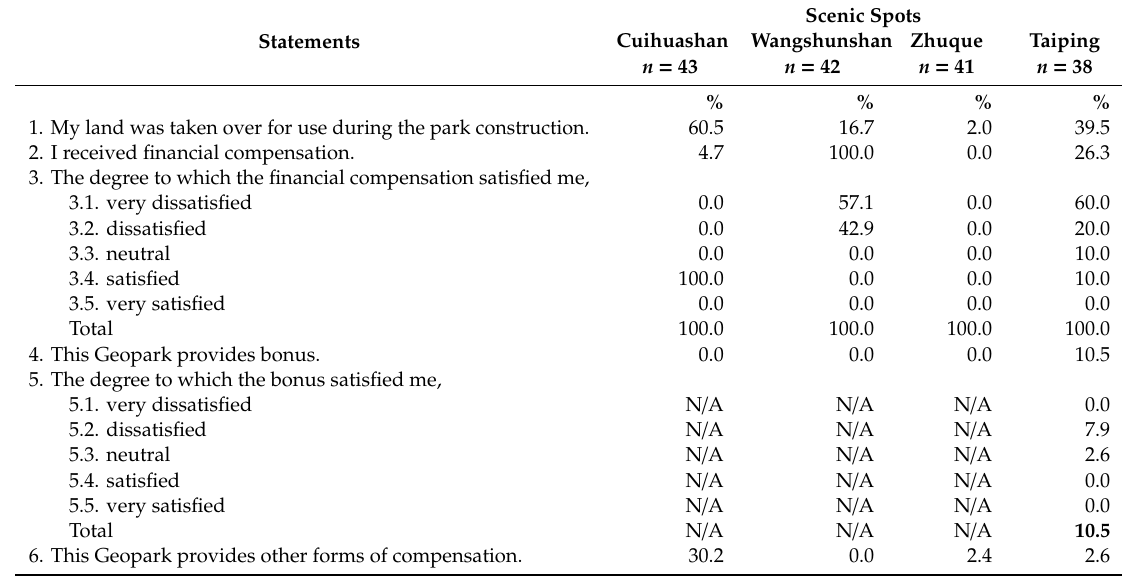
Table A4. Farmland requisitions for